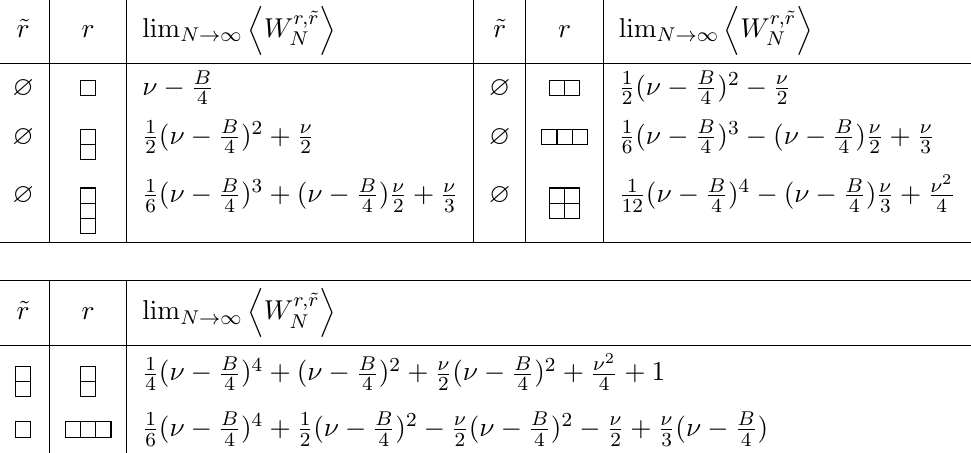
Table 1 . Some large N limit evaluations of Wilson